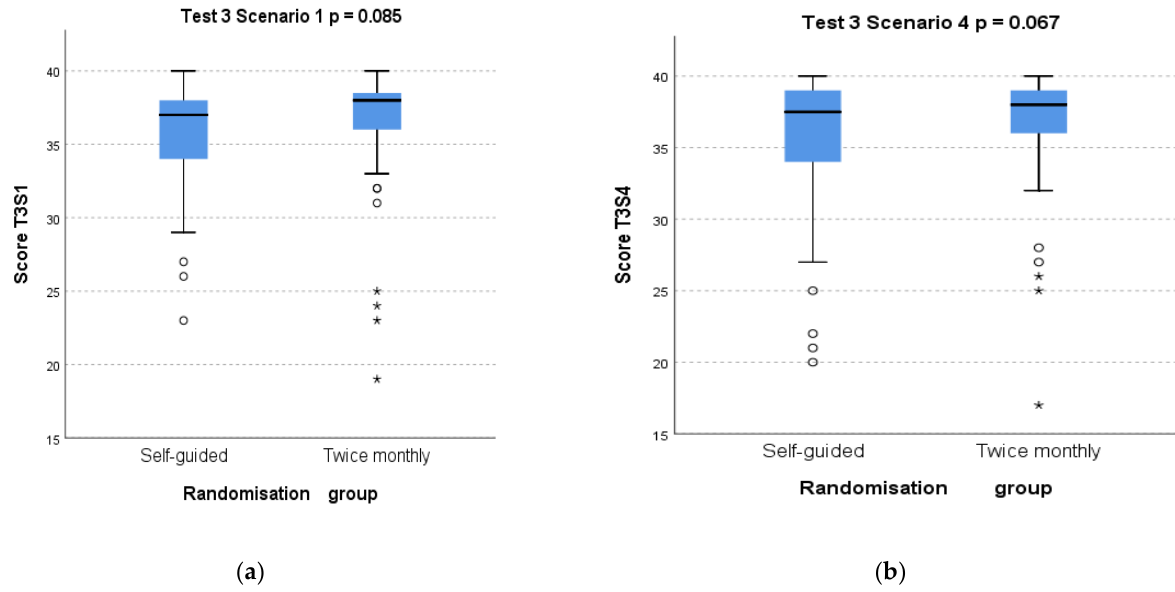
Figure 3. Box plots of test T3 scores for scenario S1 ( a ) and scenario S4 ( b ) according to randomisation group.